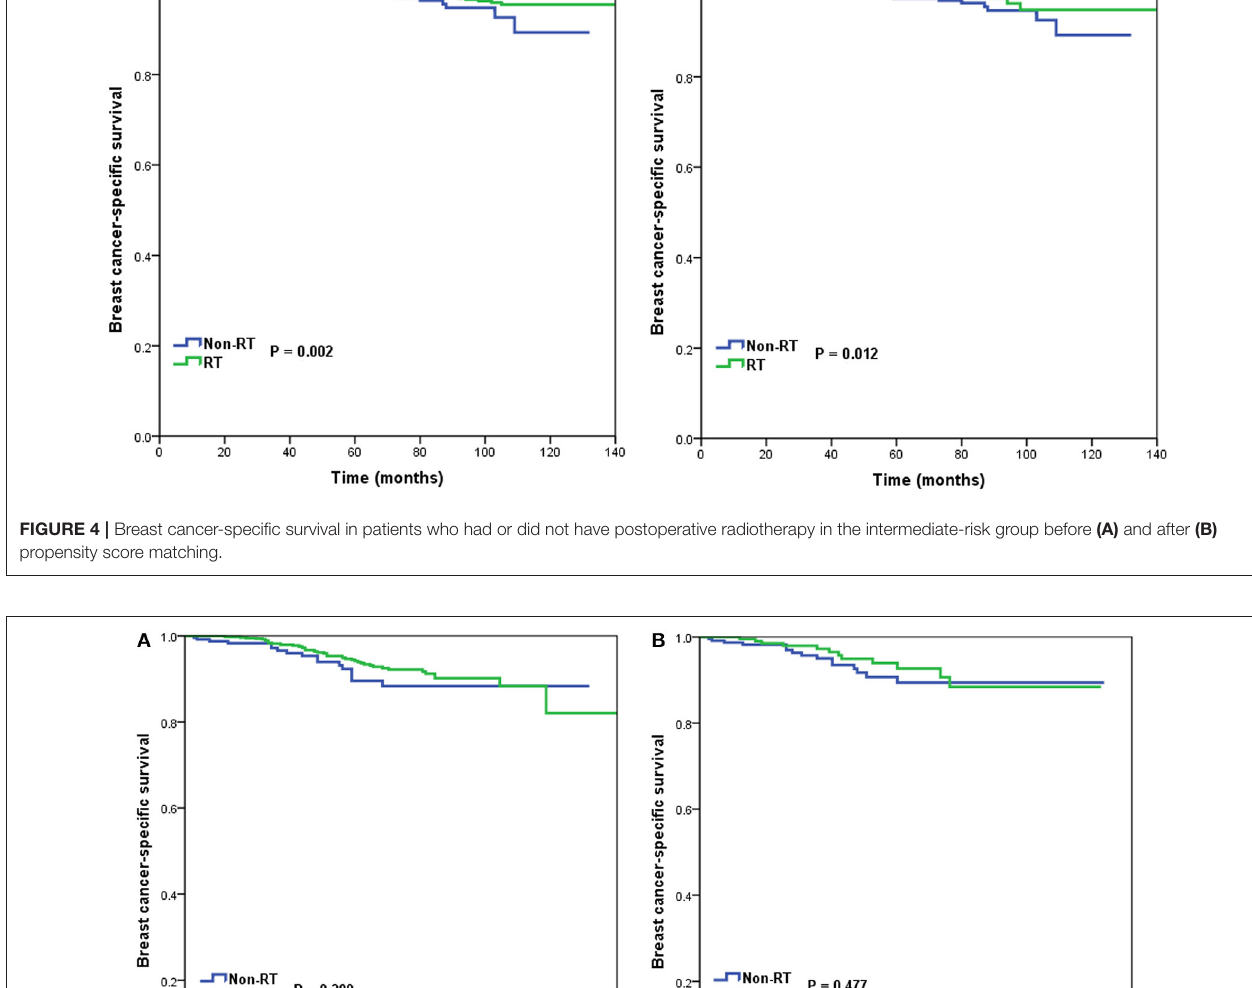
(14, 15, 23). Therefore, it is hypothesized that adjuvant RT after higher